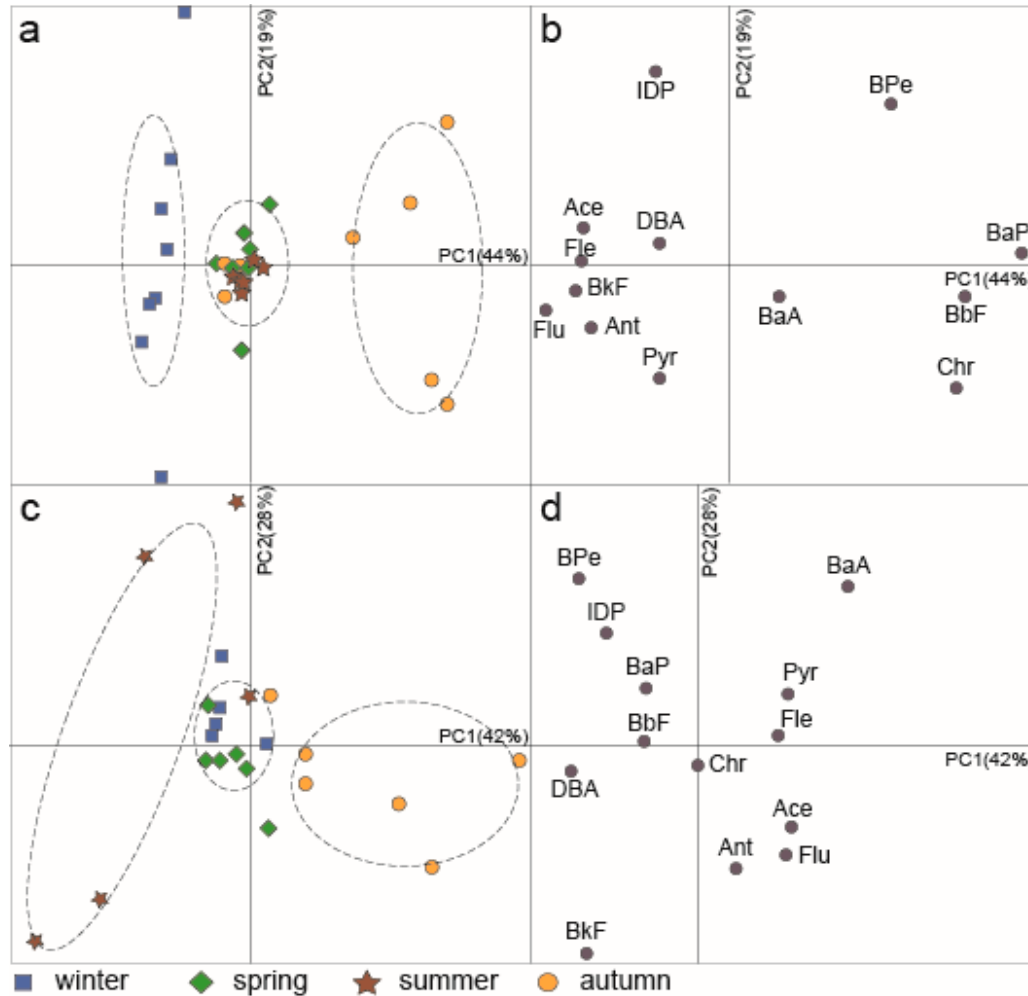
Figure 5. Principal component analysis (PCA) scores for the Partizanskaya River Estuary ( a ) and Tumen River Estuary ( c ). The seasons are differentiated by symbols. The dashed lines outline a grouping by season. The PCA loading plots for PAHs in the Partizanskaya River Estuary ( b ) and Tumen River Estuary ( d ).